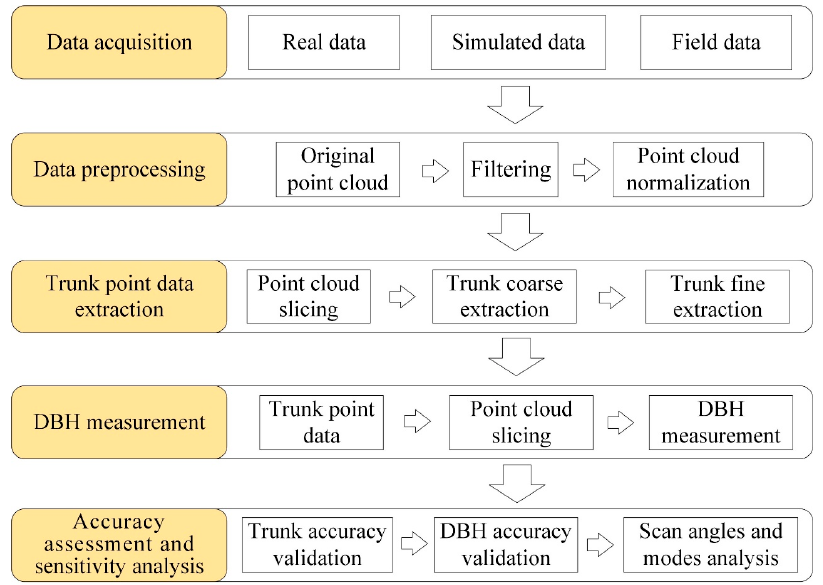
Figure 4. The overall flow